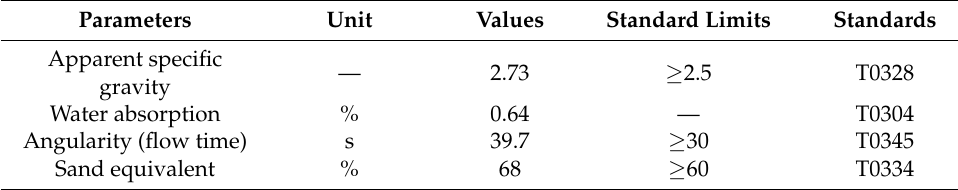
Table 3. Basic physical parameters of fine aggregate.